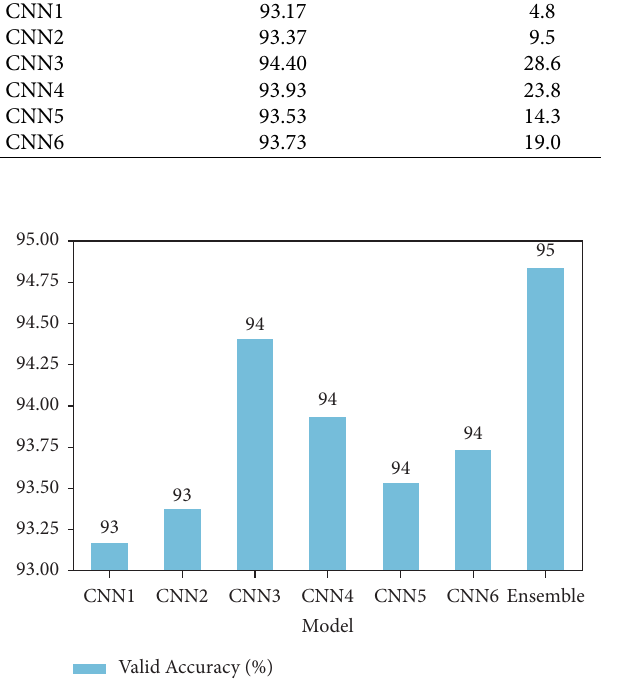
Figure 5: Effort of each